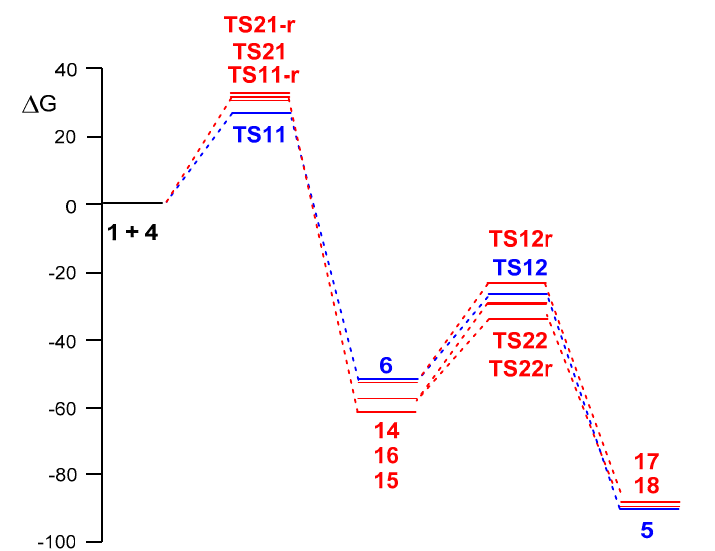
Figure 3. MPWB1K/6-311G(d) Gibbs free energy profiles, G in kcal·mol − 1 , for the competitive reaction paths associated with the domino reaction of diphenyl NI 1 with allenoate 4 yielding spirobipyrazoline 5 computed at 25 °C in DCM.